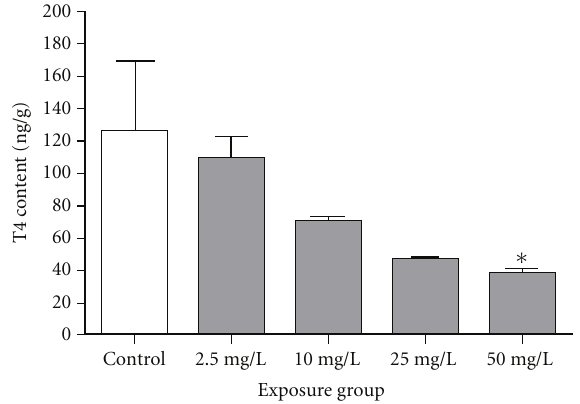
Figure 3: Whole body contents of T4 in zebrafish ( Danio rerio ) exposed to 0, 2.5, 10, 25, and 50mg/L PTU. Results are given as means ± SEM from three samples per replicate. Asterisks indicate significant di ff erences between exposure and control groups ( ∗ P < 0 . 05; Dunn’s